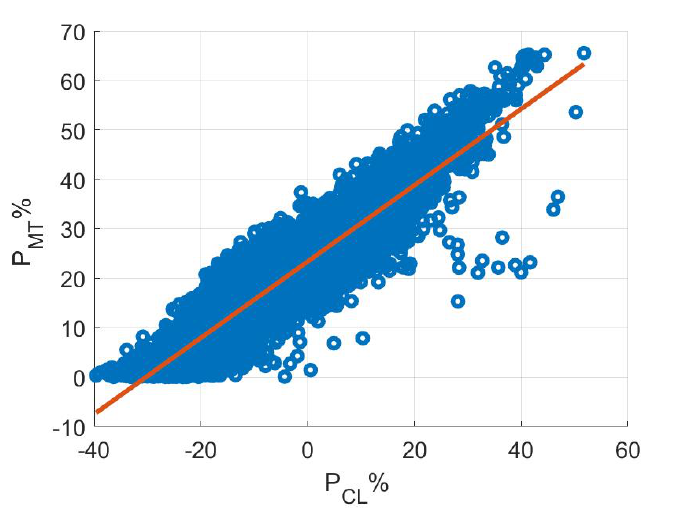
Figure 14. Improvement percentage in computational load versus Improvement percentage in maneuver time. The tendency of the CL is shown by the red average